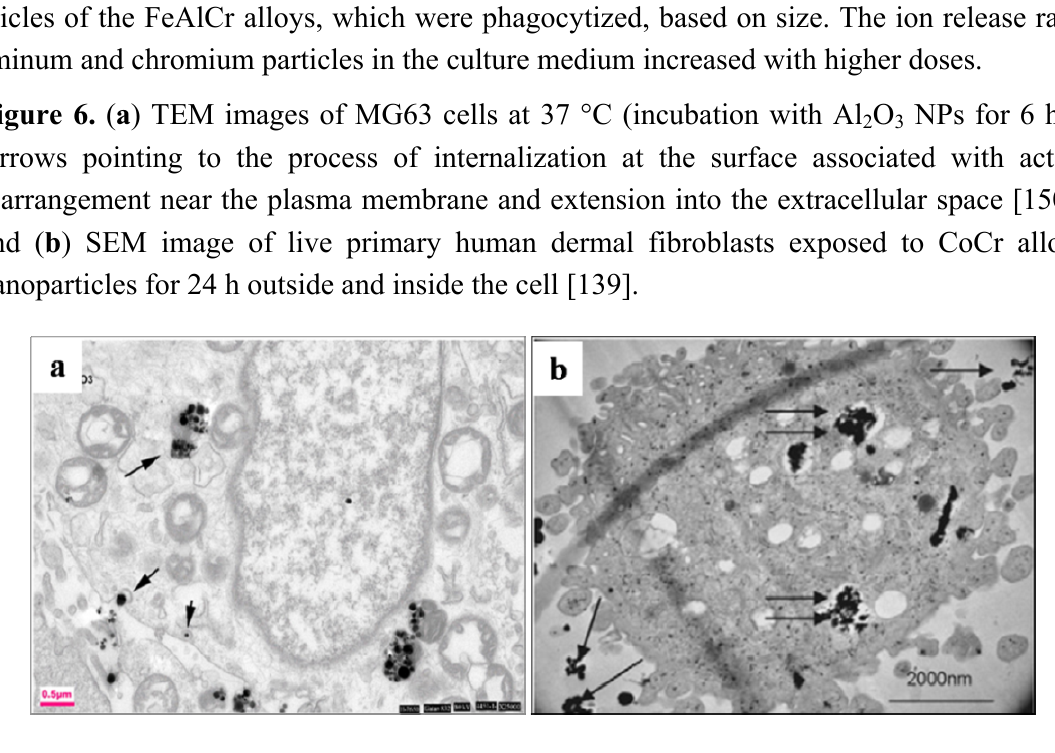
Figure 7. ( a ) Saos-2 cells challenged for 24 h with 0.5 mg/mL of FeAlCr alloys (avg. dia. 3.7 ± 0.4) and ( b ) Mineral formation after 21 days by Saos-2 cells added with 1 mg/mL of FeAlCr alloys